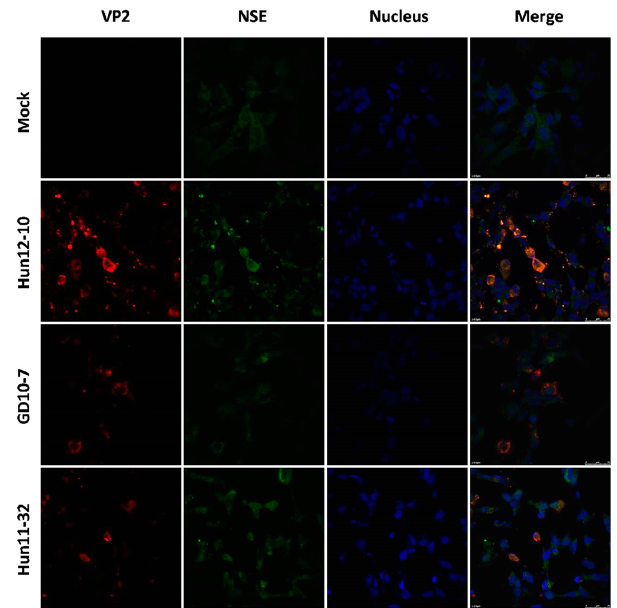
Viruses 2017 , 9 , 351